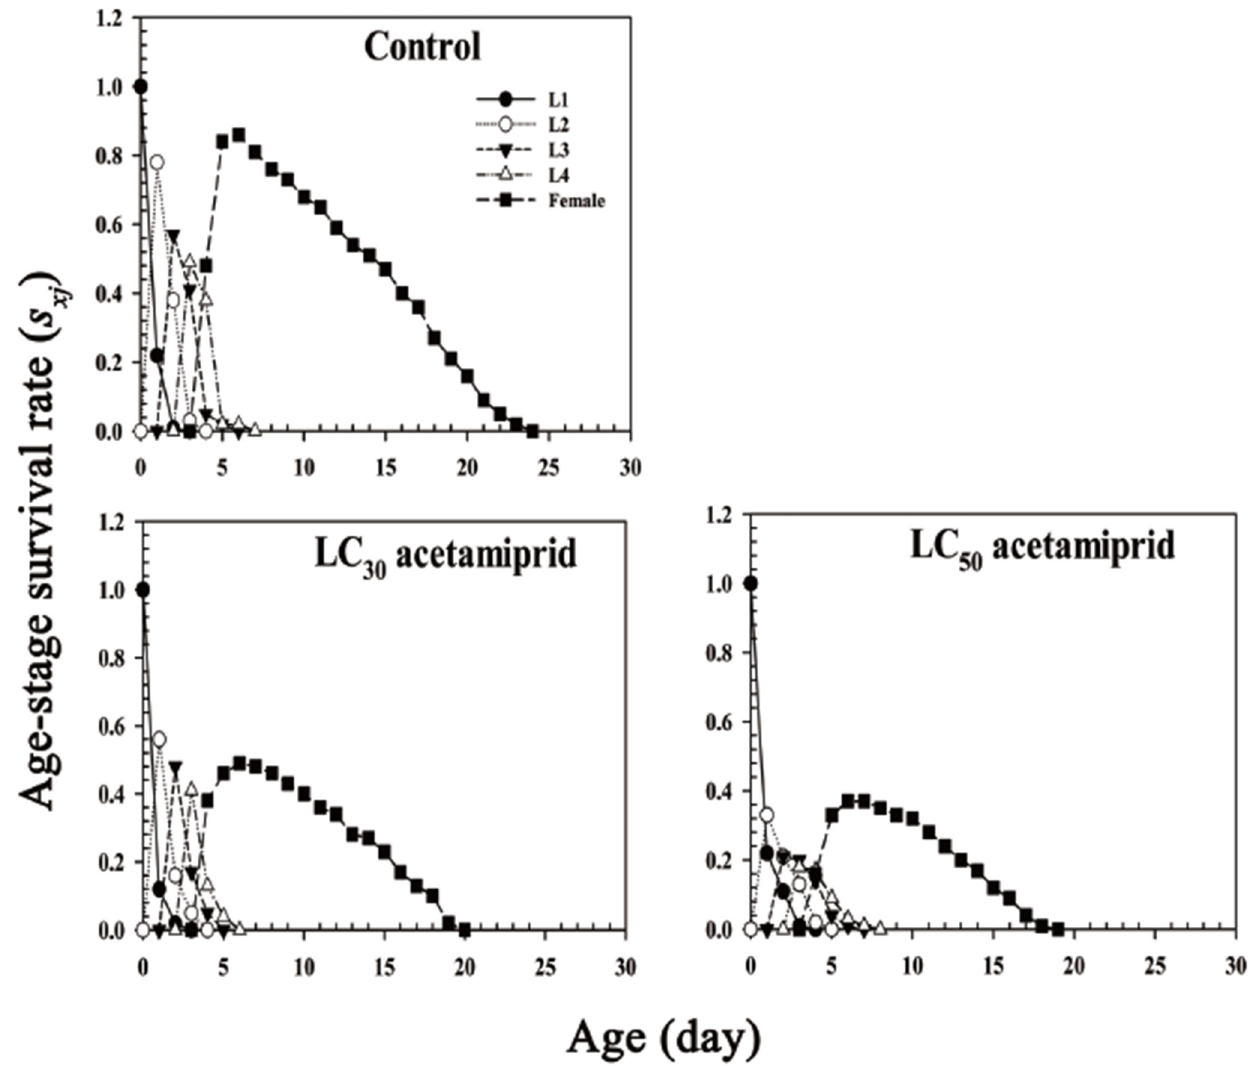
Figure 1. Age-stage specific survival rate ( s xj ) of Aphis glycines. The s xj of Aphis glycines were exposed to the following treatments: control, acetamiprid LC 30 , and acetamiprid LC 50 . L1, L2, L3, and L4 represent s xj of the first, second, third, and fourth instar nymphs,